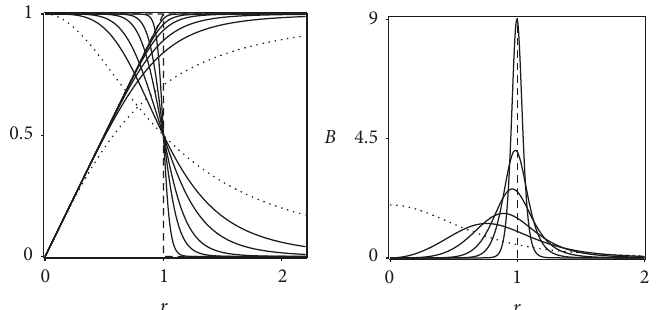
Figure 4: In the left panel, we display the solutions 𝑎(𝑟) (descending lines) and 𝑔(𝑟) (ascending lines) in (36). In the right panel, we show the magnetic field in (38). The dotted lines represent the case 𝑙 = 1 and the dashed ones stand for the compact limit in (39a), (39b), and (40).